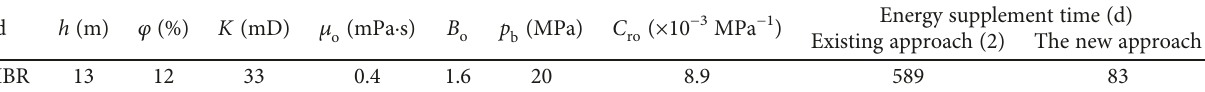
Table 4: Basic data of A-HBR fi eld.